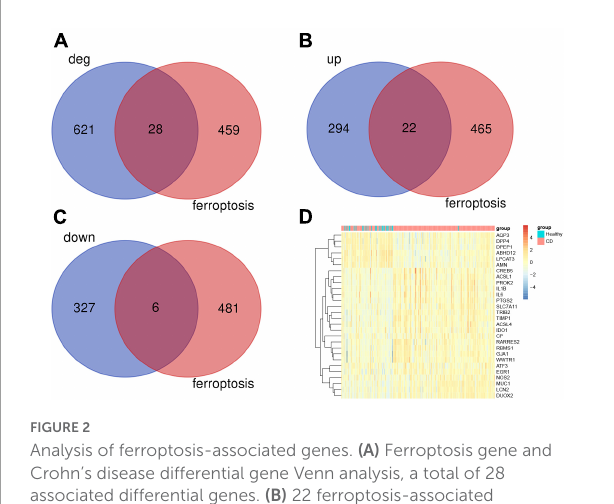
FIGURE2 Analysis of ferroptosis-associated genes. (A) Ferroptosis gene and Crohn’s disease differential gene Venn analysis, a total of 28 associated differential genes. (B) 22 ferroptosis-associated up-regulated genes. (C) 6 ferroptosis-associated down-regulated genes. (D) Heat map analysis of 28 differentially related genes associated with